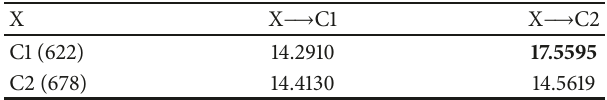
Table 2: The number of nodes in each cluster and the ratio of the numberofedgesbetweenclustersorinsidetheclustertothenumber of nodes in the cluster in Wikipedia who-votes-on-whom network with 100% of initial number of nodes in all clusters.